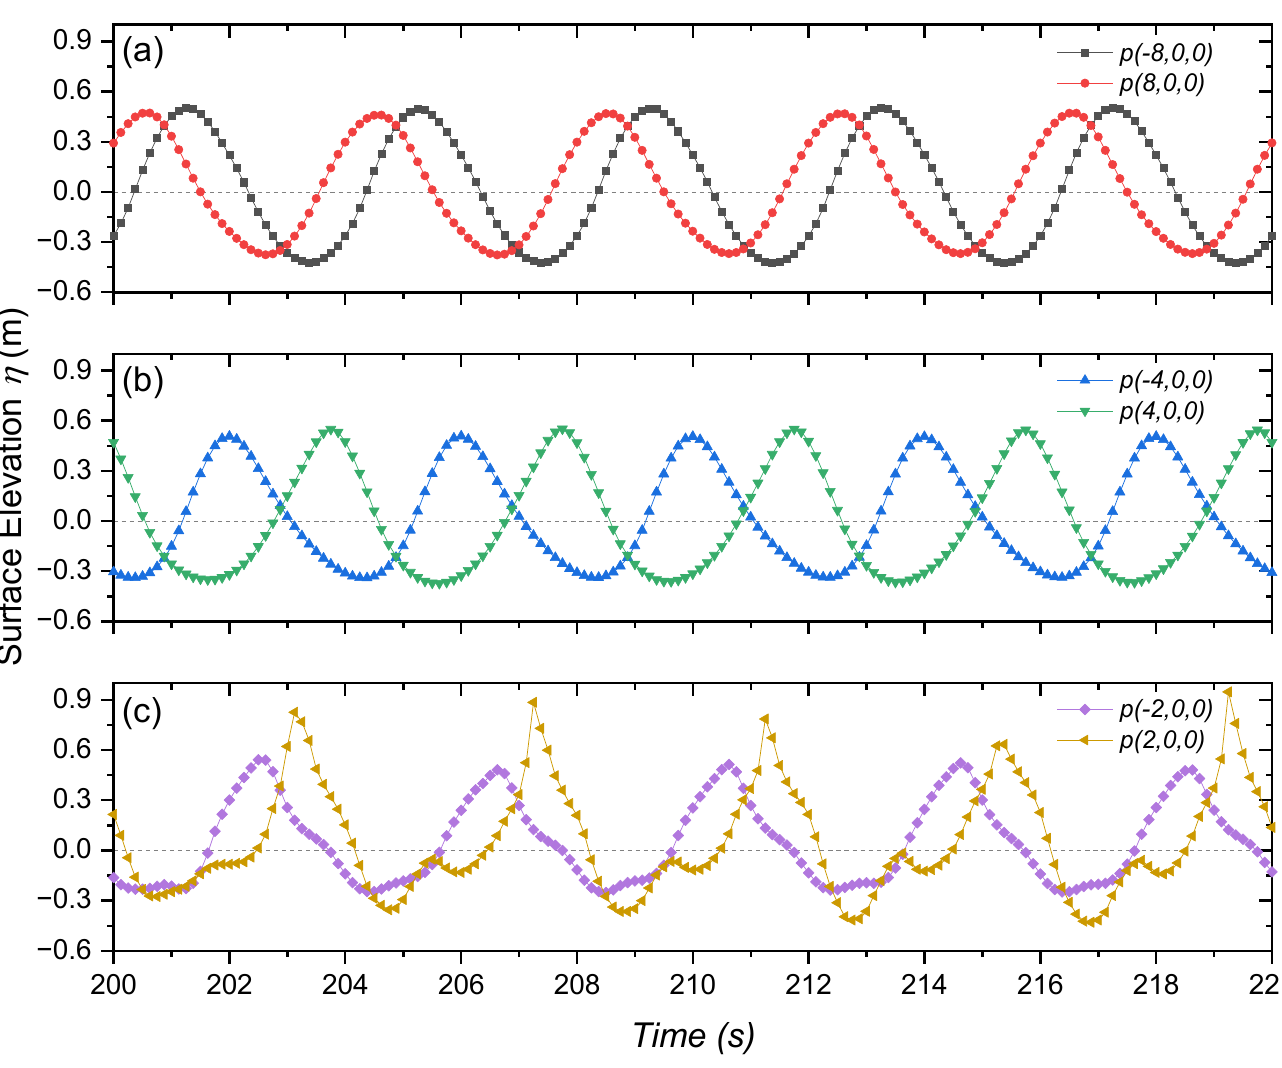
Figure 9. Surface elevation records for the test with H = 1.0 m, T = 4 s, and R = 0.25 m for virtual gauges at symmetrical distances from the buoy: ( a ) 2, ( b ) 4, and ( c ) 8 m to each side. Negative values to the left of the buoy and positive to the right.